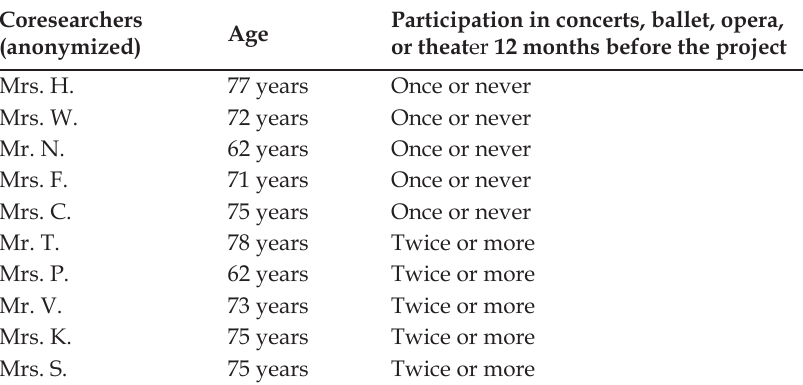
Table 1. Inclusion criteria for ten coresearchers Coresearchers Participation in concerts, ballet, Age (anonymized)